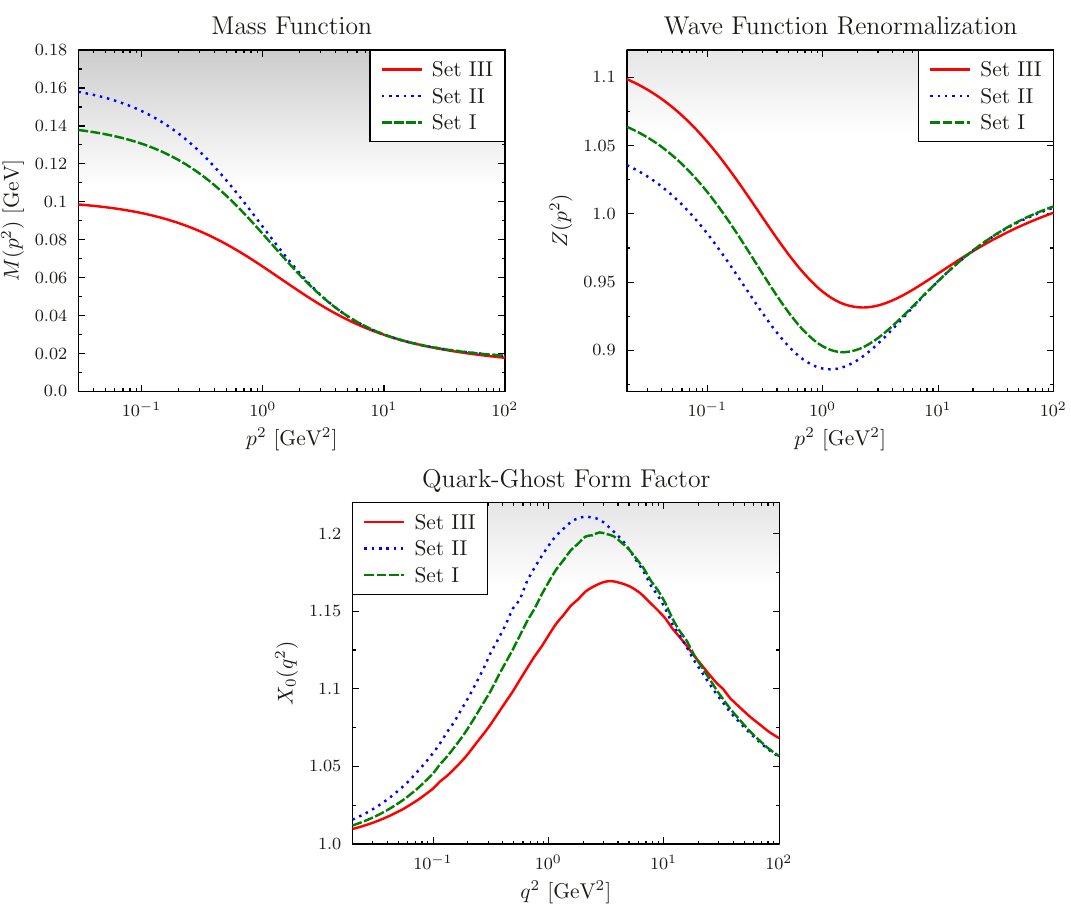
Figure 3 . Mass function, M ( p 2 ) , wave renormalization, Z ( p 2 ) , and the quark-ghost kernel form factor, X 0 ( q 2 ) , for three sets of gluon and ghost propagators, using only Γ L of eqs. (2.44)–(2.47) in the DSE (2.15). Set I [29] and II [35, 36]: α s ( µ ) = 0 . 30 , m ( µ ) = 25 MeV, µ = 4 . 3 GeV. Set III [30]: α s ( µ ) = 0 . 35 , m ( µ ) = 25 MeV, µ = 4 . 3